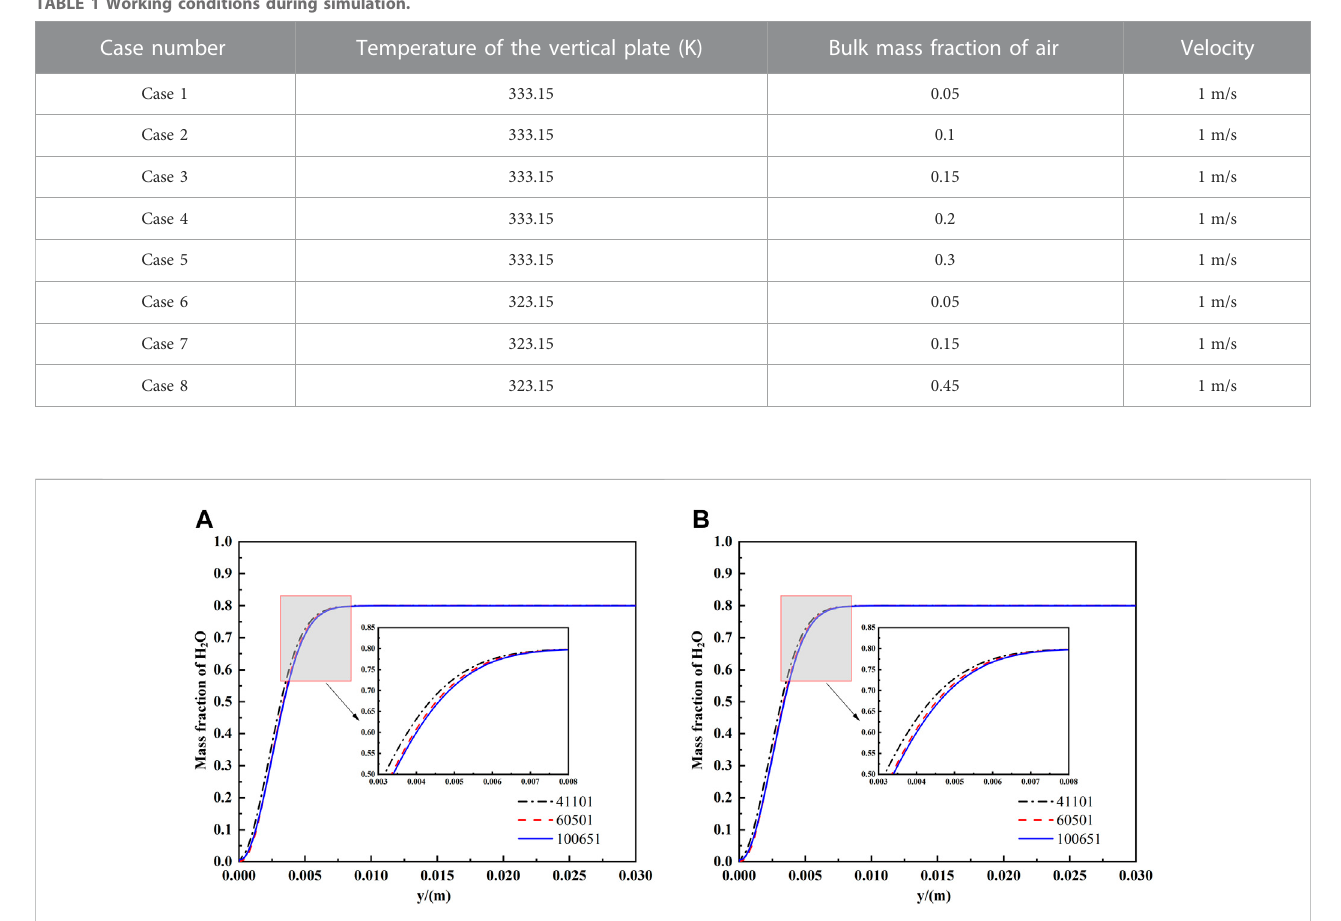
FIGURE 4 Grid independence check with the mass fraction of water vapor in the outlet at 0.75 s: (A) Case 4; (B) Case 1.